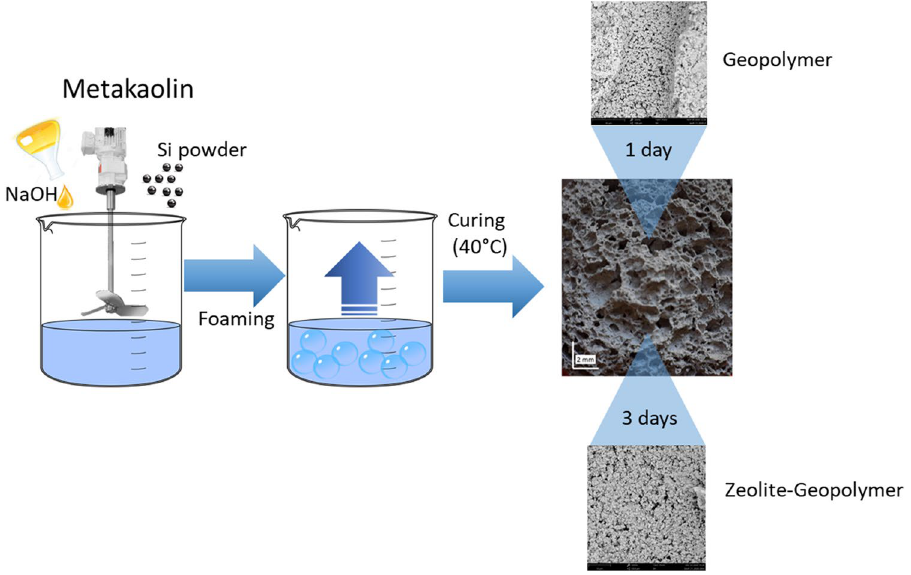
Figure 1. Softener preparation